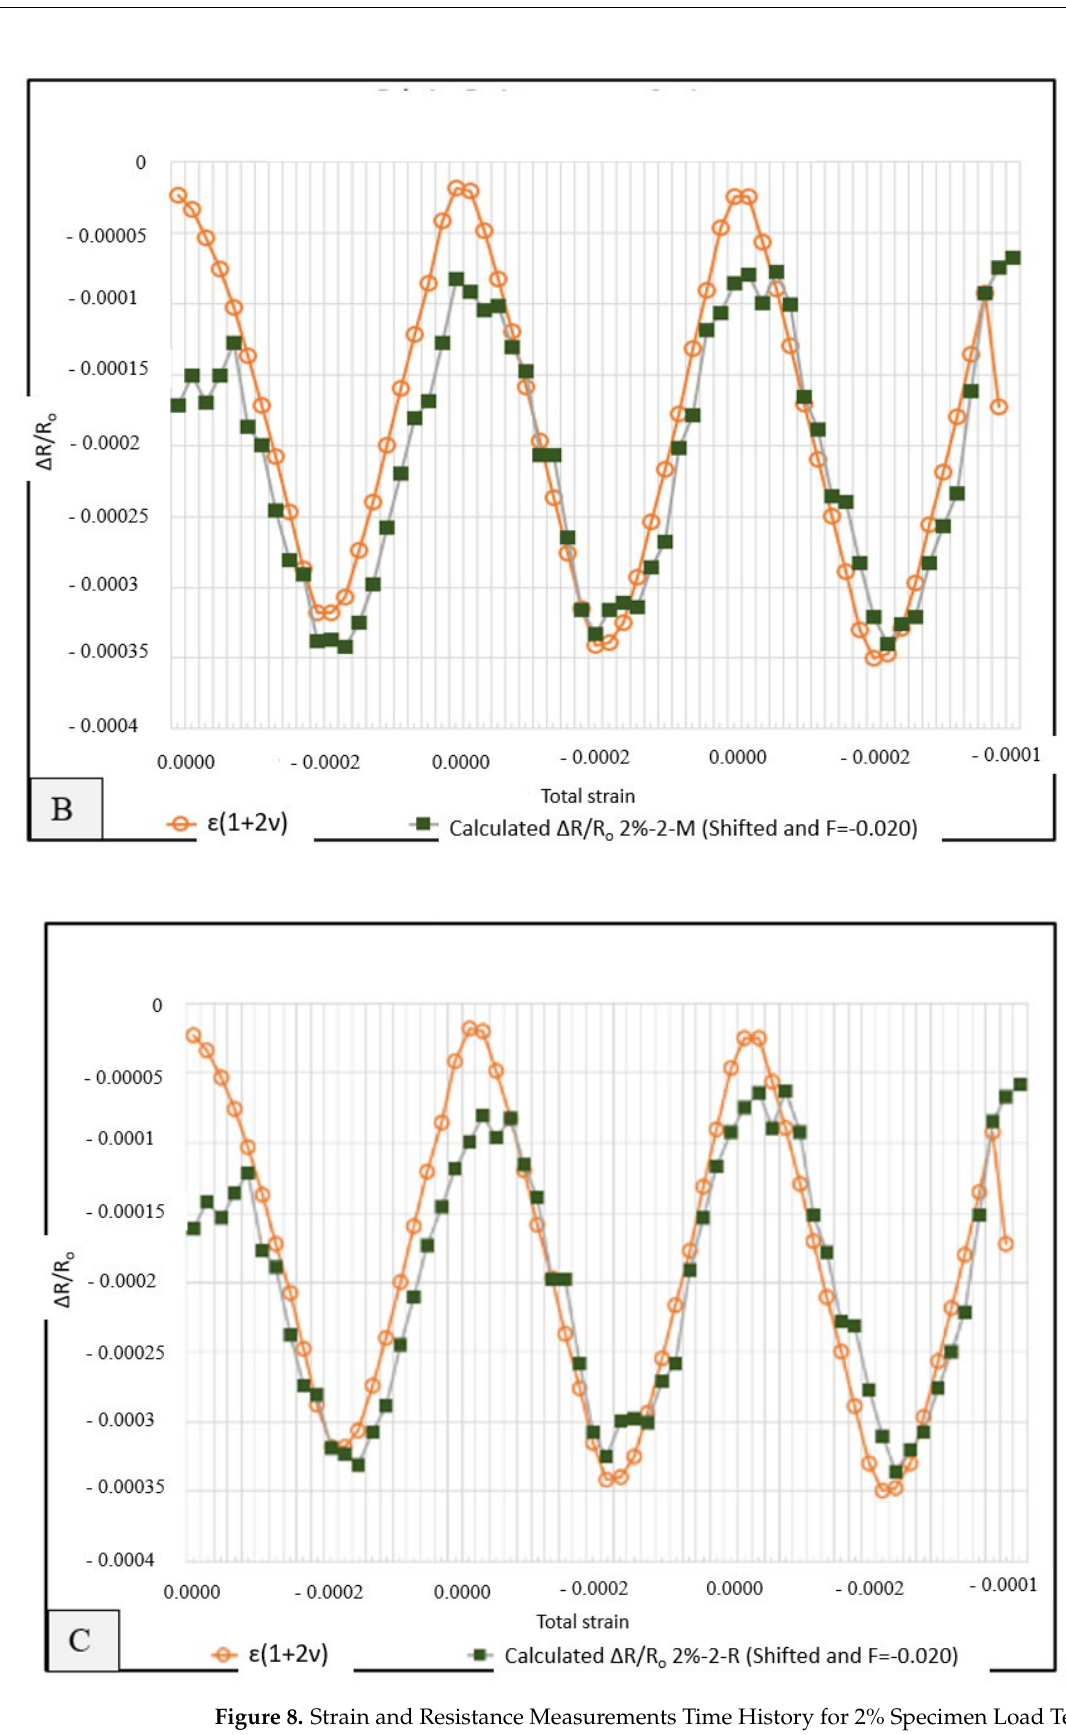
Figure 8. Strain and Resistance Measurements Time History for 2% Specimen Load Test 2: ( A ) Left Electrode, ( B ) Middle Electrode, and ( C ) Right Electrode.